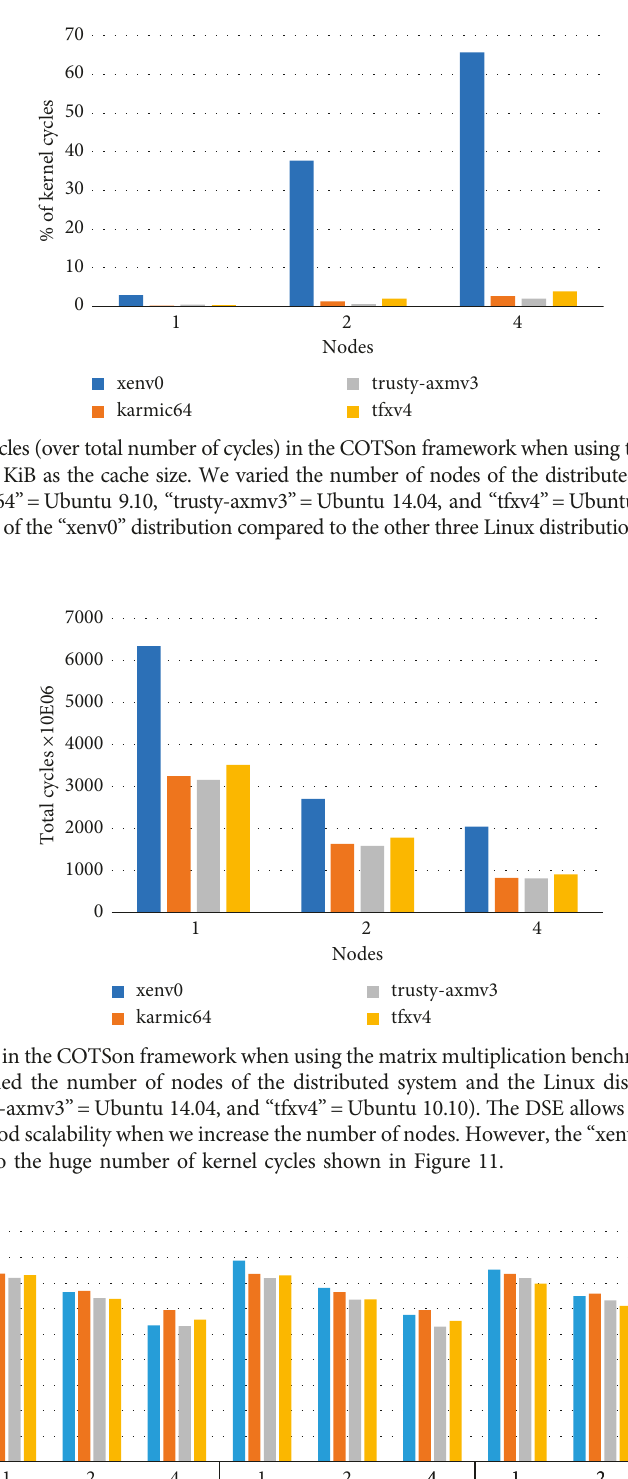
Ubuntu 16.04, “karmic64” Ubuntu 9.10, (cid:31) (cid:31)